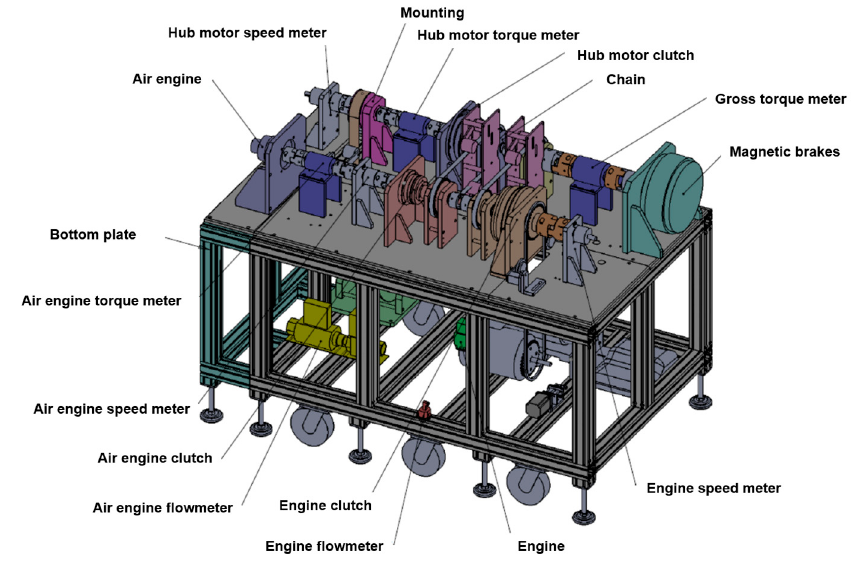
Figure 2. Scheme of the seven-mode three-power-source experimental platform.